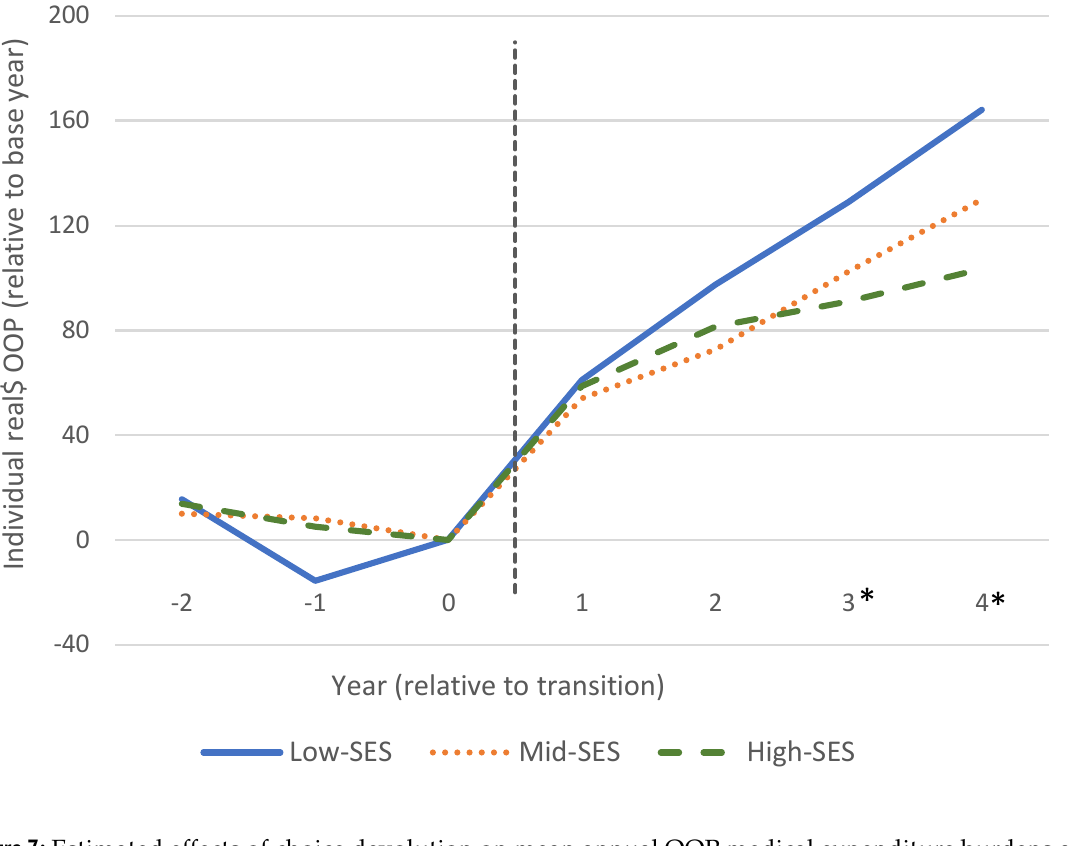
Figure 7: Estimated effects of choice devolution on mean annual OOP medical expenditure burdens among enrollees who select into high-deductible plans following choice devolution. Notes: This figure shows pooled difference-in-difference estimates of changes in OOP medical expenditures among enrollees at firms that transition to devolved choice of insurance deductible level, with the sample restricted to persons who select to enroll in an HDHP following the transition to choice. SES categories correspond to the bottom 25 percent, middle 50 percent, and top 25 percent of the sample distribution. The model is estimated with year-fixed effects and with person-fixed effects centered at the pre-devolution level. ∗ indicates a statistically significant difference between the high- and low-SES groups at p <